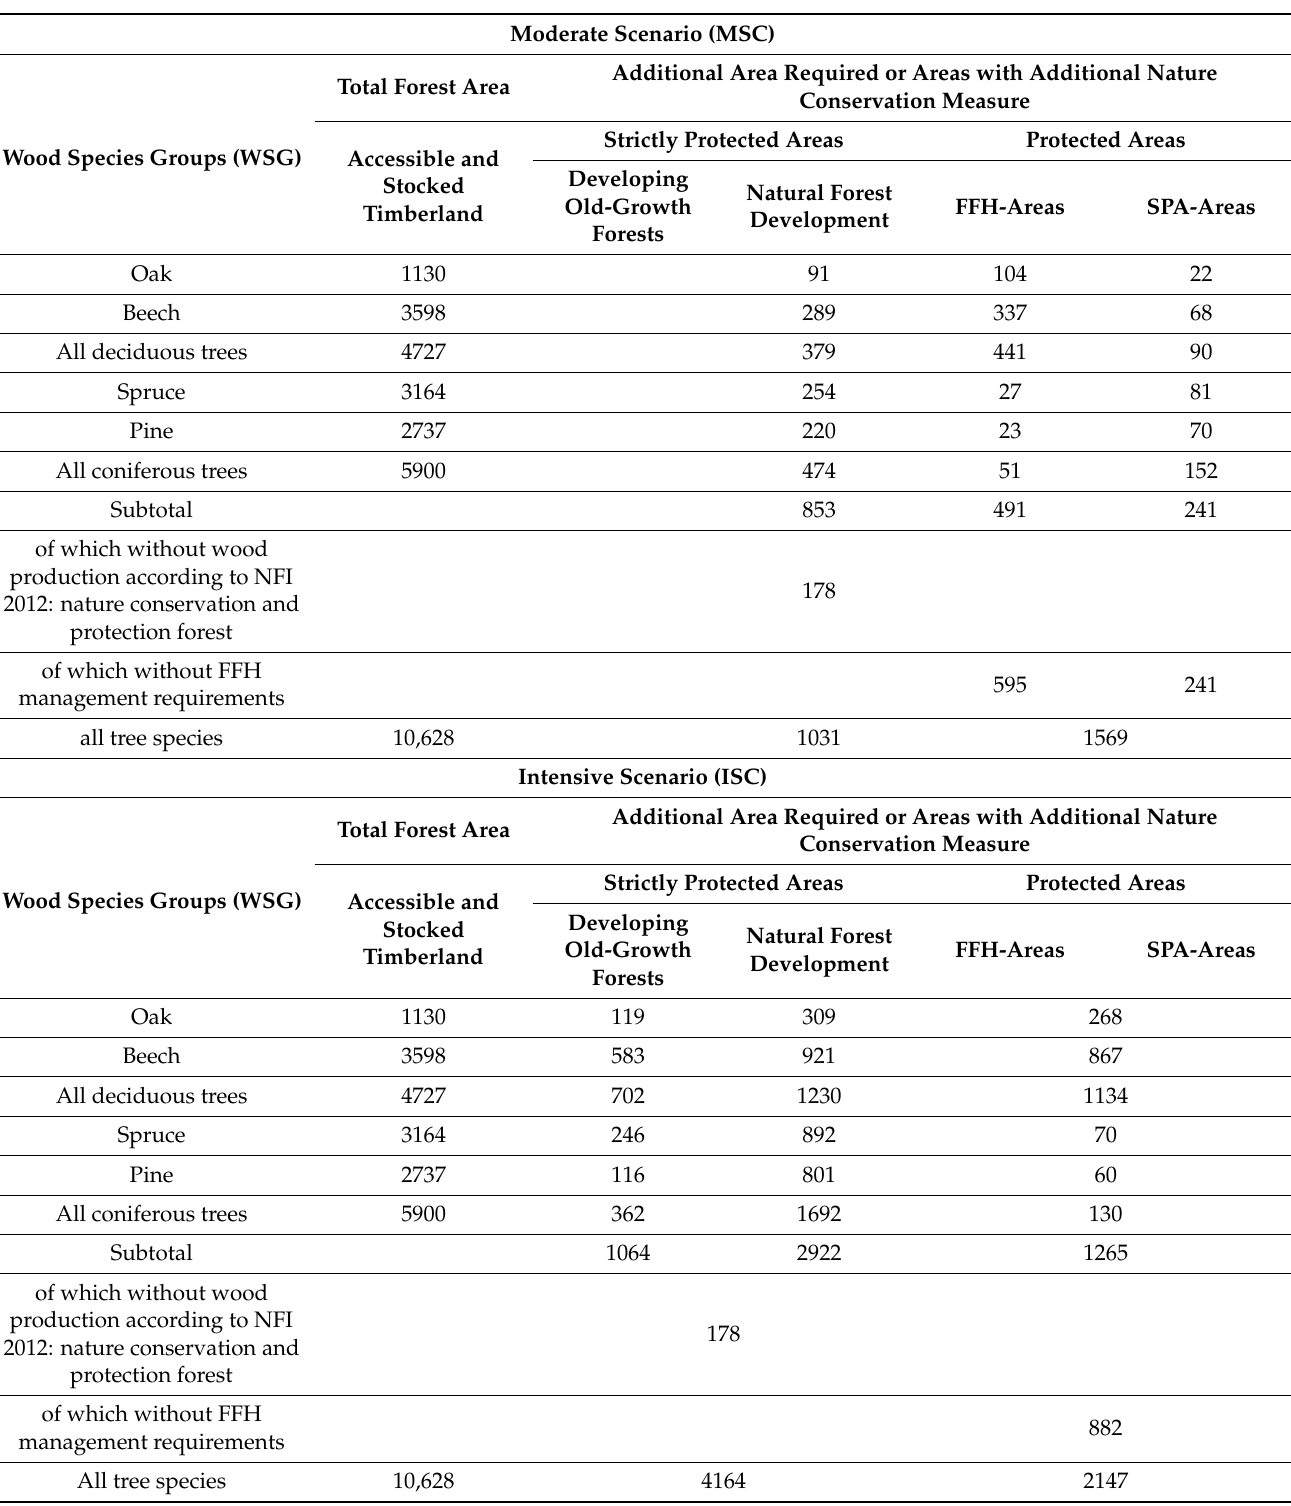
Table A5. German forest area balance sheet in 1000 ha by wood species to determine area require- ments for MSC and ISC (in 1000 ha) [authors’